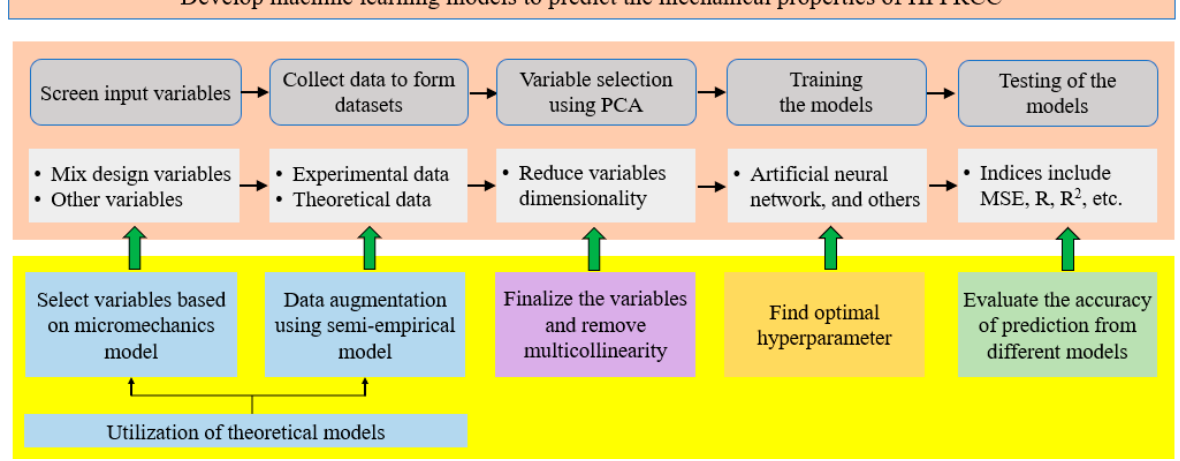
Figure 5. Illustration of the innovation of methodology for prediction of the mechanical properties of HPFRCC by integrating data-driven and model-based methods.